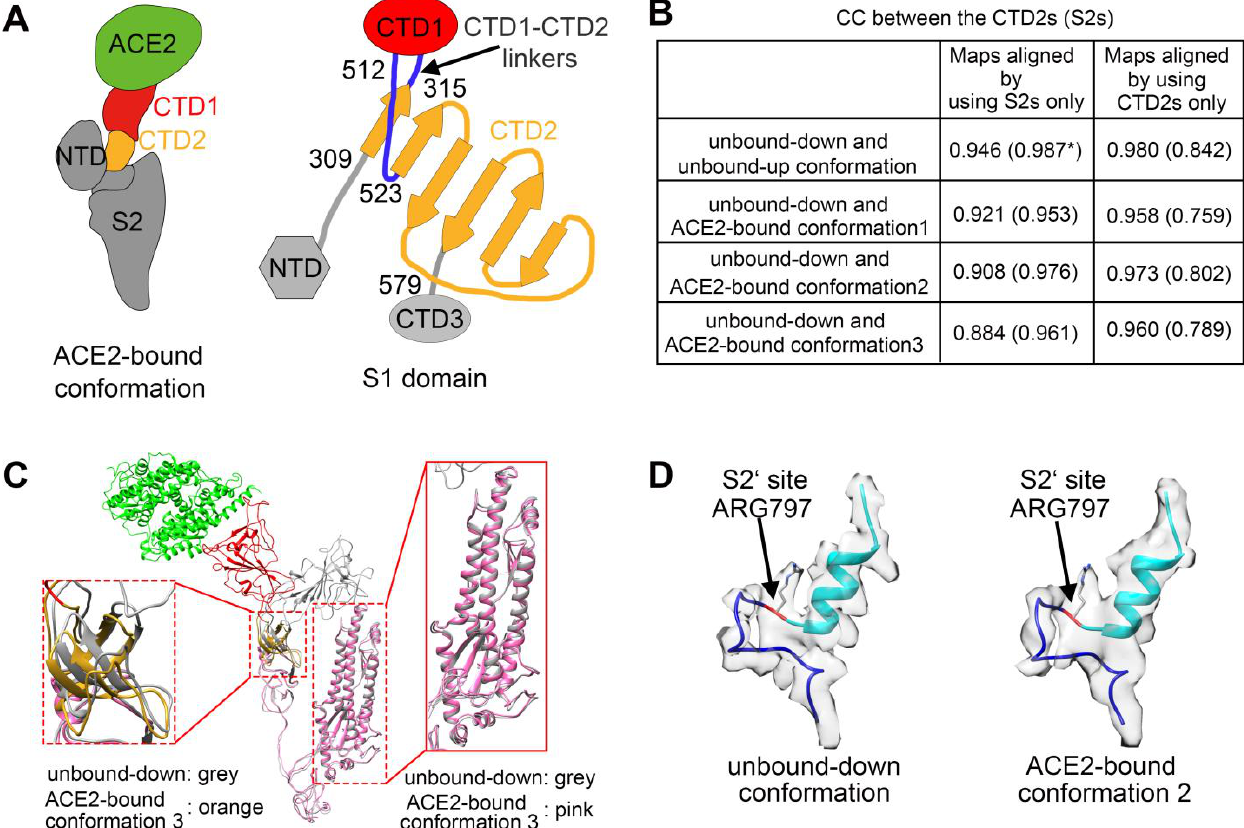
Figure 3: Courtesy reference number 24. Structural comparisons of the ACE2-bound and ACE2-free SARS-CoV spikes. (A) Schematic and topology diagrams showing the domain organization. NTD, CTD3 and S2 are colored grey, CTD1 is colored red, CTD2 is colored orange, CTD1-CTD2 linkers are colored blue. (B) Cross-correlation coefficients (CCs) between the CTD2s or the S2s of different conformations. *Values in the parentheses are the CCs between the S2s of different conformations. Density maps were low-pass filtered to 5.5 Å and were compared at a contouring level of 4.0 σ. (C) Ribbon-diagram structural comparisons of the ACE2-bound conformation 3 and the unbound-down conformation. ACE2, CTD1, CTD2, CTD3 and S2 of the ACE2-bound conformation 3 are colored green, red, yellow, pink and pink respectively. The unbound-down conformation is colored grey. CTD2 and S2 domain are zoomed in to show the receptor-binding induced hinge motion of CTD2. (D) EM densities and corresponding atomic models represented in ribbon diagrams around the S2’ protease cleavage site: unbound-down conformation (left) and ACE2- bound conformation (right). The S2’ site is colored red and position of the S2’ site is indicated with black arrows. The fusion peptide is colored cyan. The “C” shape loop covering the S2’ site is colored